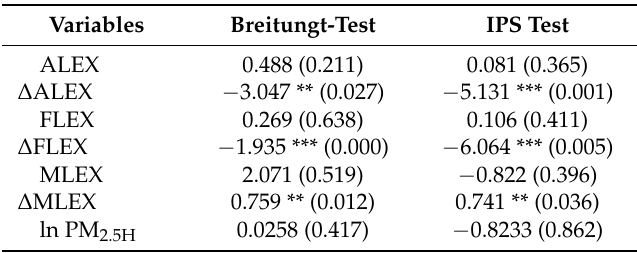
Table 2. Results of panel unit root